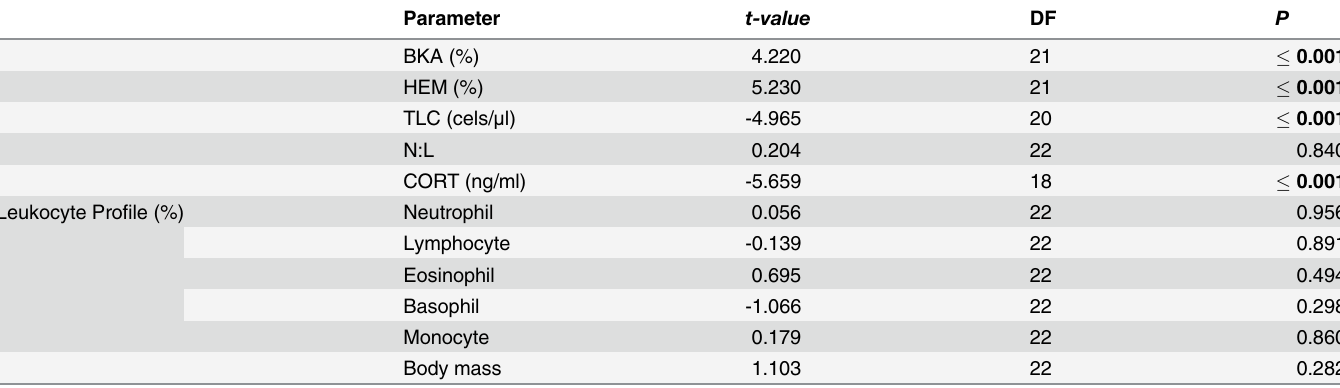
Table 2. Comparison between blood parameters and body mass for individuals of R . icterica under field conditions and after long-term captivity (three